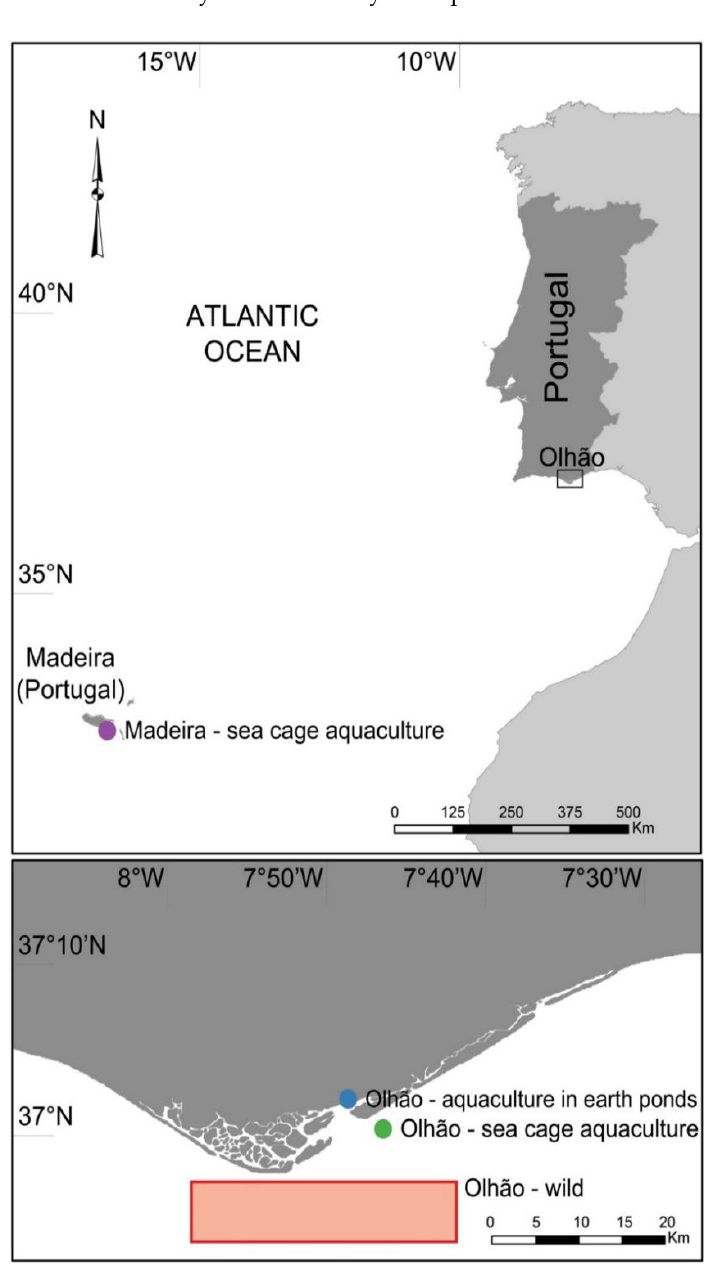
Figure 1. Location of wild and aquaculture collections of Sparus aurata in the southern Portuguese mainland coast (Olhão) and Madeira archipelago and from three fish production methods as fol- lows: Olhão – wild (Owild), Olhão – aquaculture in earth ponds (Opond), Olhão – sea-cage aquacul- ture (Ocage) and Madeira – sea-cage aquaculture (Mcage).